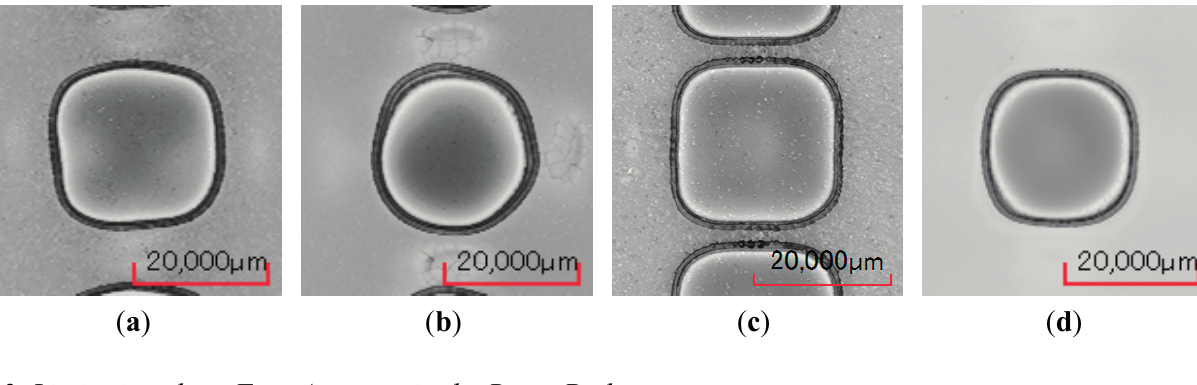
Figure 6. Images of the ablated geometry with the beam shapers in the focal position and displaced by 100 μ m in the z -direction. ( a ) FBS-1 z -shift = 0 , v = 0.31. ( b ) FBS-1 z -shift = 0.1 mm, v = 0.39. ( c ) FBS-2 z -shift = 0, v = 0.18. ( d ) FBS-2 z -shift = 0.1 mm, v =